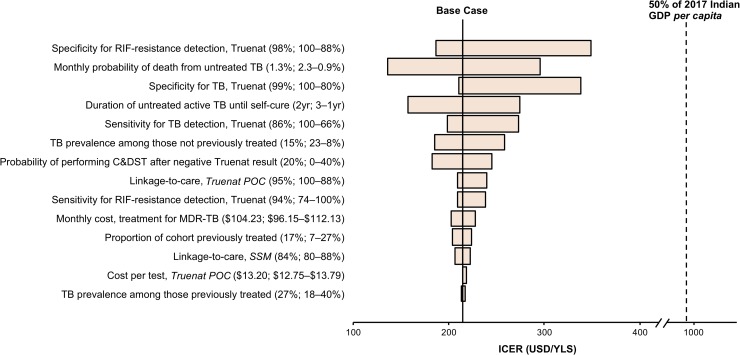
One-way sensitivity analyses of key model parameters, comparing Truenat POC to SSM, at lifetime horizon.TB: tuberculosis. MDR-TB: multidrug-resistant tuberculosis. RIF: rifampicin. C&DST: culture and drug-susceptibility test. yr: year. POC: point-of-care. “previously treated”: previously treated for TB. GDP: gross domestic product. ICER: incremental cost-effectiveness ratio. USD: United States dollars. YLS: year-of-life saved. Horizontal bars represent ranges of ICERs when varying each model parameter across its plausible range. The vertical dashed line represents 50% of the GDP per capita of India in 2017 ($990), which we consider the cost-effectiveness threshold (see Methods). ICERs less than $990/YLS (left of dashed line) are considered cost-effective.